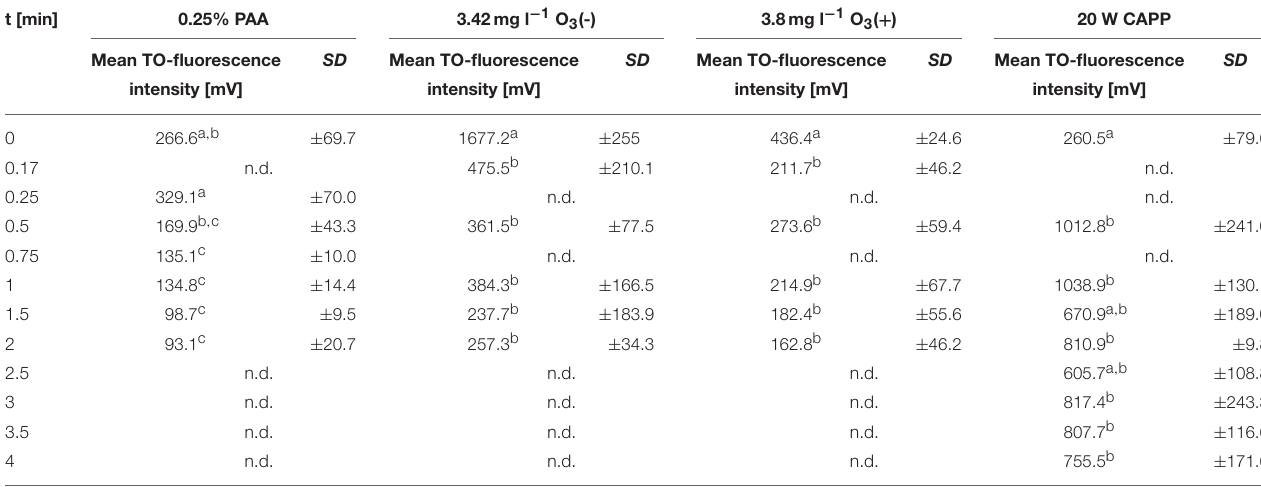
TABLE 3 | Mean TO-fluorescence intensity of L. innocua after different